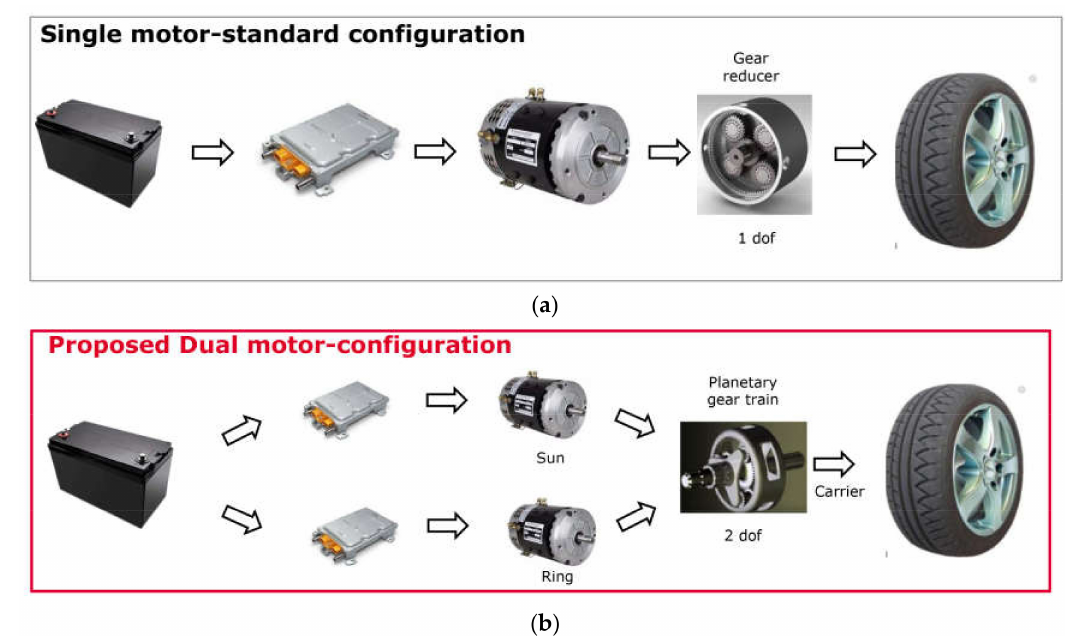
Figure 1. Functional schemes of the standard single-motor, single-speed powertrain ( a ) and the proposed dual-motor multispeed system ( b